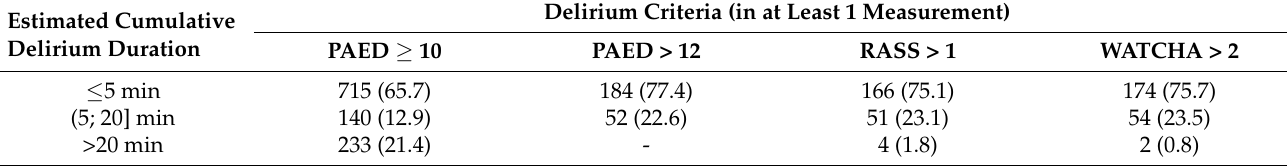
Figure 3. The assessment of delirium over time during hospitalization in the PACU. The dashed line for each scoring system indicates the threshold above which the patient was identified as positive. Table 4. The estimated cumulative duration of